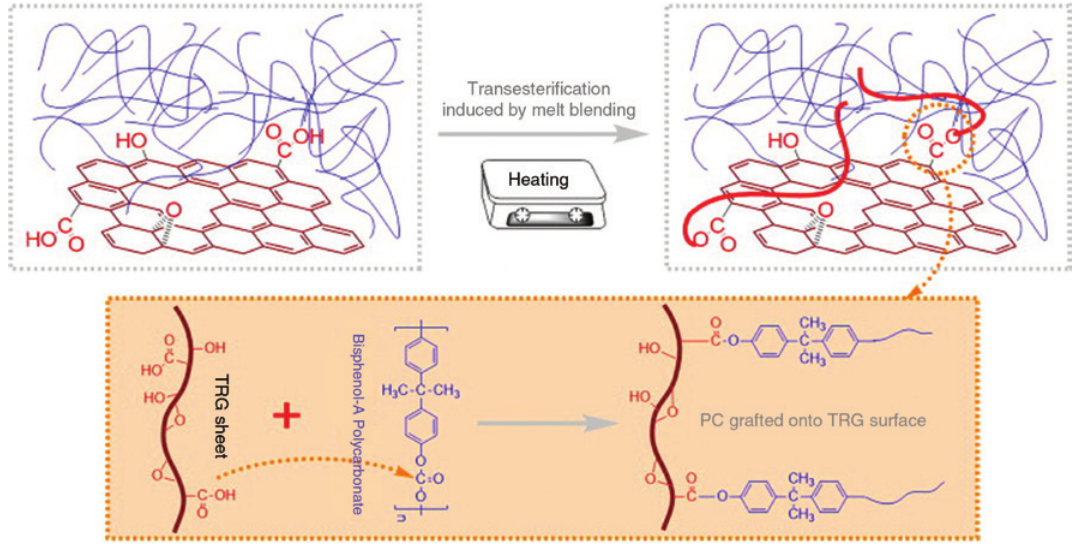
Figure 6: Schematic diagrams of the transesterification between the carbonate groups in PC chains and the carboxyl groups on TRG sheets at high temperature during melt blending